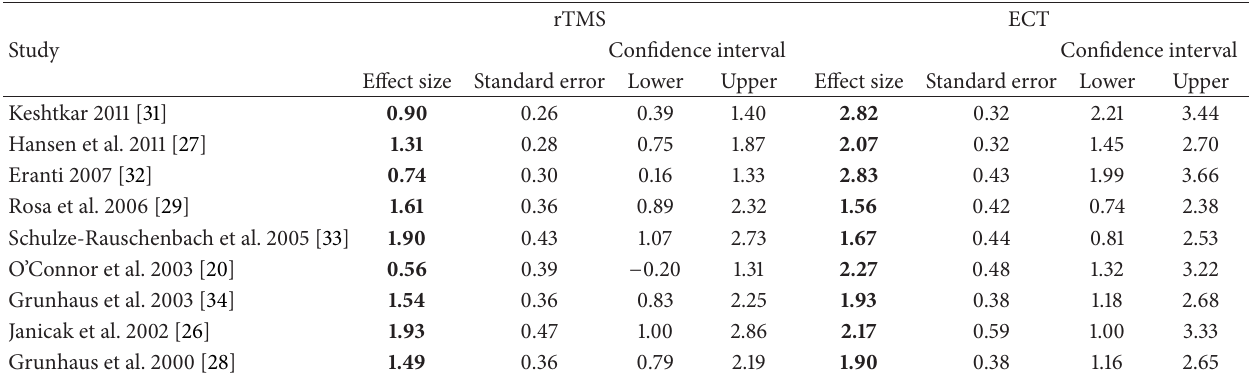
Table 2: Bias corrected (Hedges) effect sizes for each study.